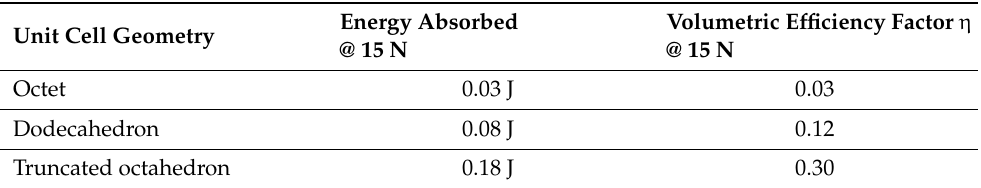
Table 3. Energy absorption and volumetric energy absorption efficiency of various 2nd order hierarchical lattices.